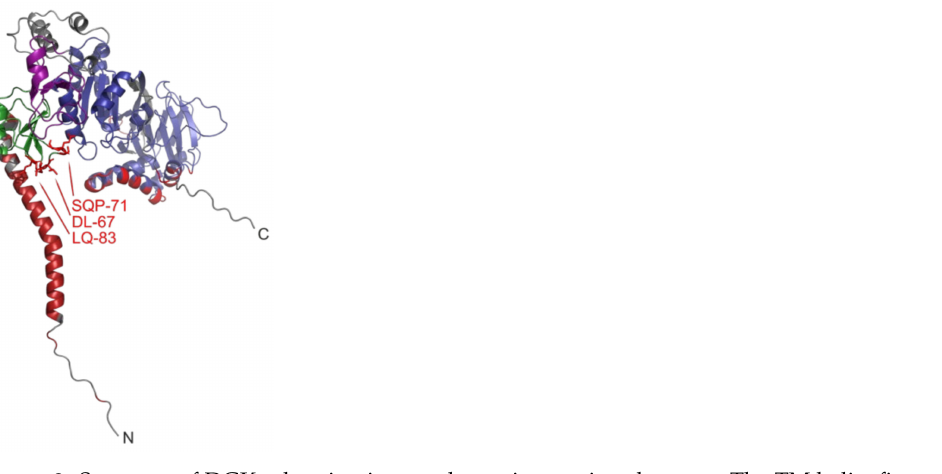
Figure 3. Structure of DGK ε showing its membrane interactive elements. The TM helix, first and second C1 domains and catalytic domain of the AlphaFold2 model are colored dark red, green, magenta and blue, respectively. The rest of the backbone ribbon is gray. The residues in the peripheral domains with scores of at least 30 are red, with the sidechains of those of the first C1 domain drawn as sticks and labelled. The N- and C-termini are